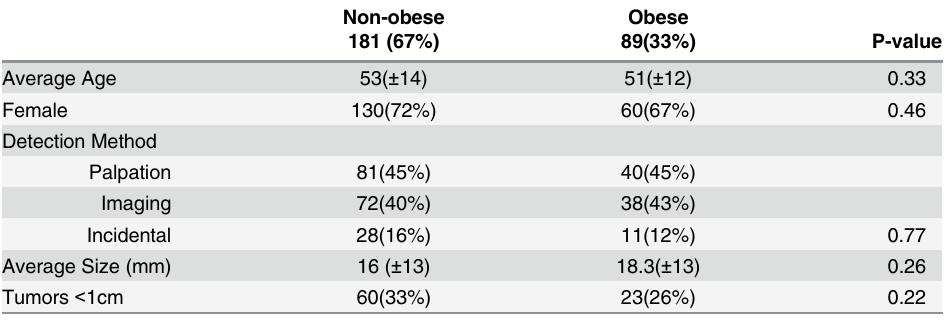
Table 2. Comparison of Obese patients to Non-obese